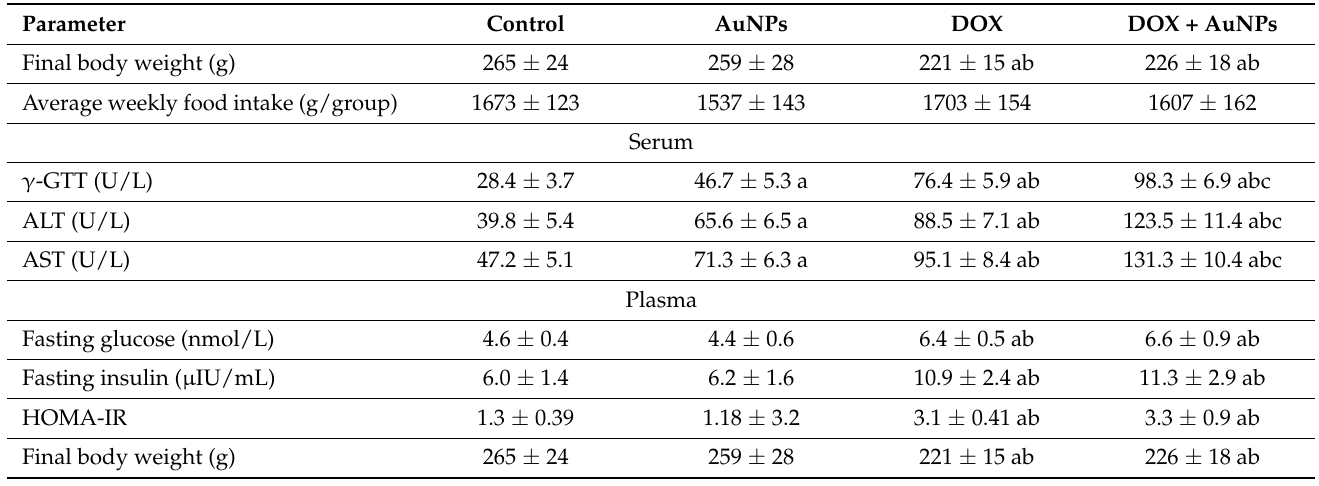
Table 1. Effects of the individual or combined treatments with gold nanoparticles (AuNPs) and/or doxorubicin (DOX) on body weights, food intake, liver enzymes, and plasma glucose and insulin levels in all groups.